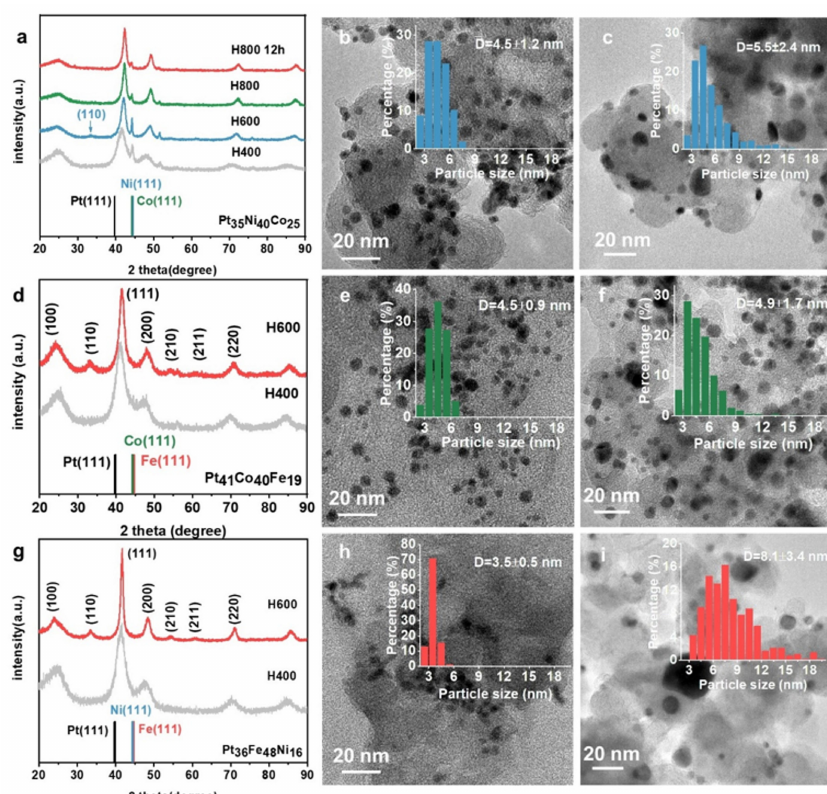
Figure 1. The XRD patterns and TEM images of ternary alloys after annealing. ( a , d , g ) XRD patterns; ( b , c , e , f , h , i ) TEM images and corresponding particle size distributions of PtNiCo, PtCoFe, and PtFeNi annealed at 400 ◦ C and 600 ◦ C,